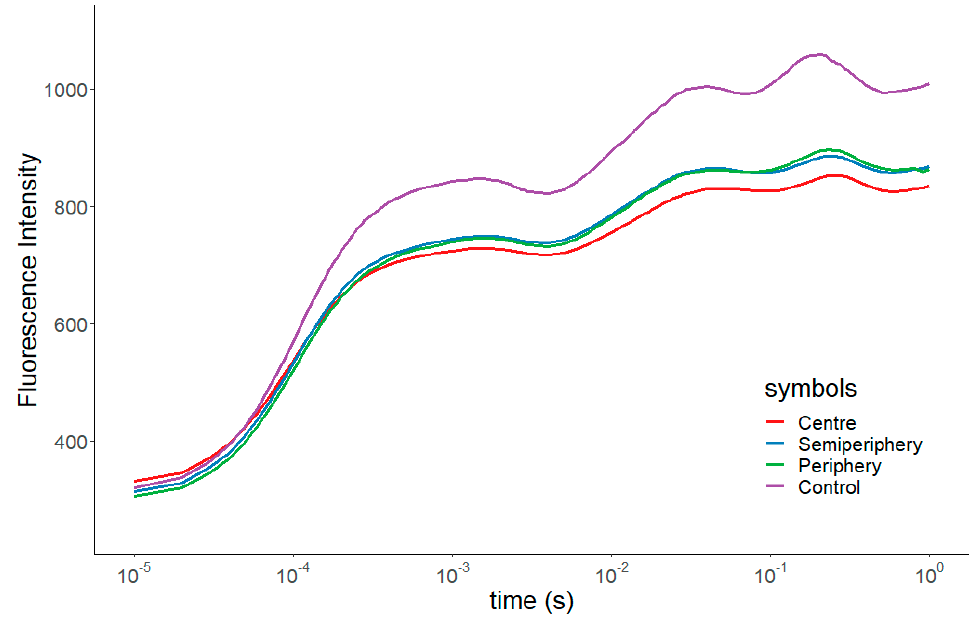
Figure 4. OJIP transients in control samples and in samples exposed in the three concentric belts.